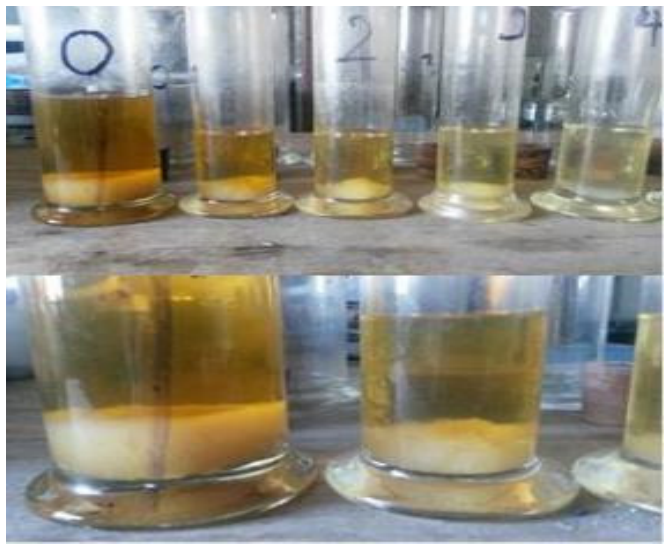
Figure 2. Tar and wax captured in isopropanol.